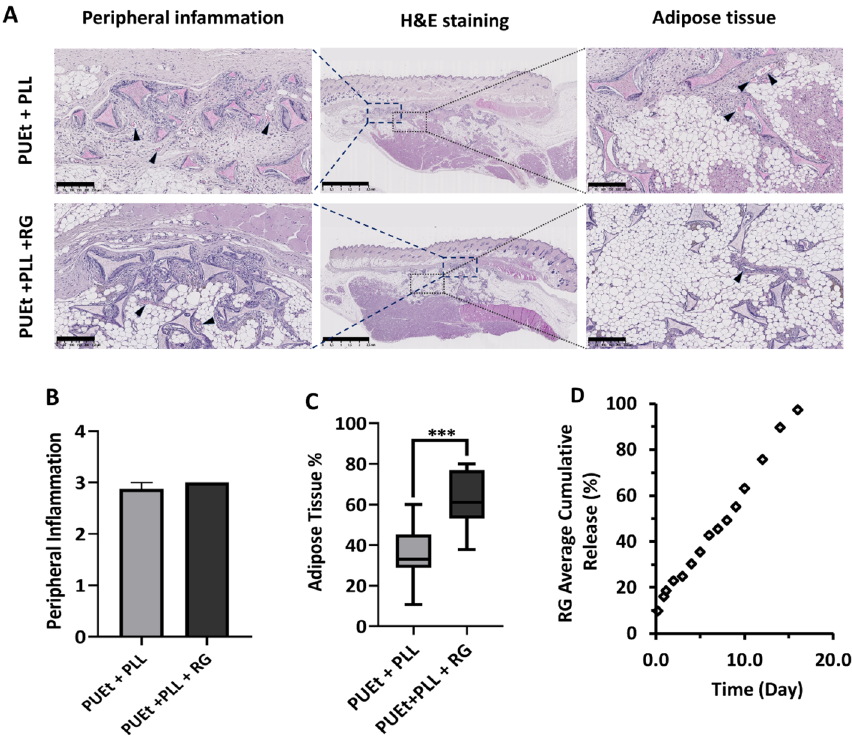
Figure 4. ( A ) representative H&E stained histological images of PUEt + PLL (control) and PUEt + PLL + RG. In the middle: low-magnitude images showing the entire explanted scaffolds after 3 months of subcutaneous implantation. Rectangular regions were selected to show peripheral inflammation and adipose tissue (dashed blue and dotted gray, respectively), scale bar = 2.5 mm. Left and right columns are high-magnitude selected images representing the peripheral inflammation and adipose tissue in each group, respectively. Vascular tissue is indicated by black arrowheads (scale bar, 250 µm). ( B ) graphical representation of peripheral inflammation of PUEt + PLL (control) and PUEt + PLL + RG. No significant difference between the 2 groups was found, in terms of peripheral inflammation. ( C ) Graphical representation of the adipose tissue %. The semi-quantification of adipose tissue % was carried out according to the method described in paragraph 4.14 and in Fig. 3. Statistically relevant differences in terms of % of adipose tissue was found between PUEt + PLL + RG and PUEt + PLL (control) (*** p < 0.01). ( D ) Graphical representation of the in vitro cumulative release of RG from PUEt + PLL + RG, under physiological conditions. The release profile is characterized by a 9.35% initial